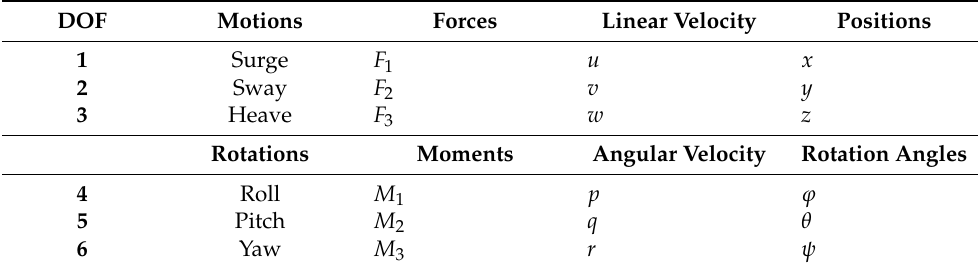
Table 1. Notation of motion